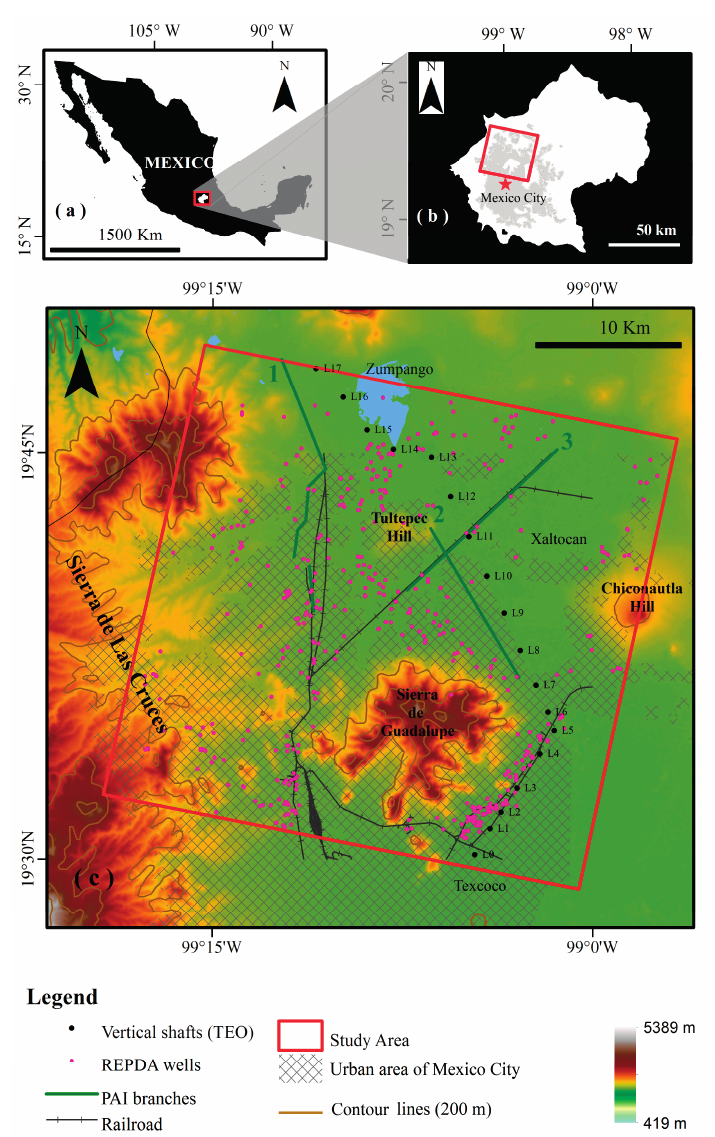
Figure 1. ( a ) Location of the Mexico Basin; ( b ) SBAS area of analysis (red square) within the Mexico Basin (white area). The ZMVM is represented in grey and the capital Mexico City indicated by the red star; ( c ) Main features of the study area are represented: Mountainous range, hills and ancient lakes (Texcoco, Xaltocan and Zumpango). Railways and the TEO vertical shafts are depicted, as well as, the Registro Publico de Derechos de Agua (REDPA) and the Pozos de Accion Inmediata (PAI) well